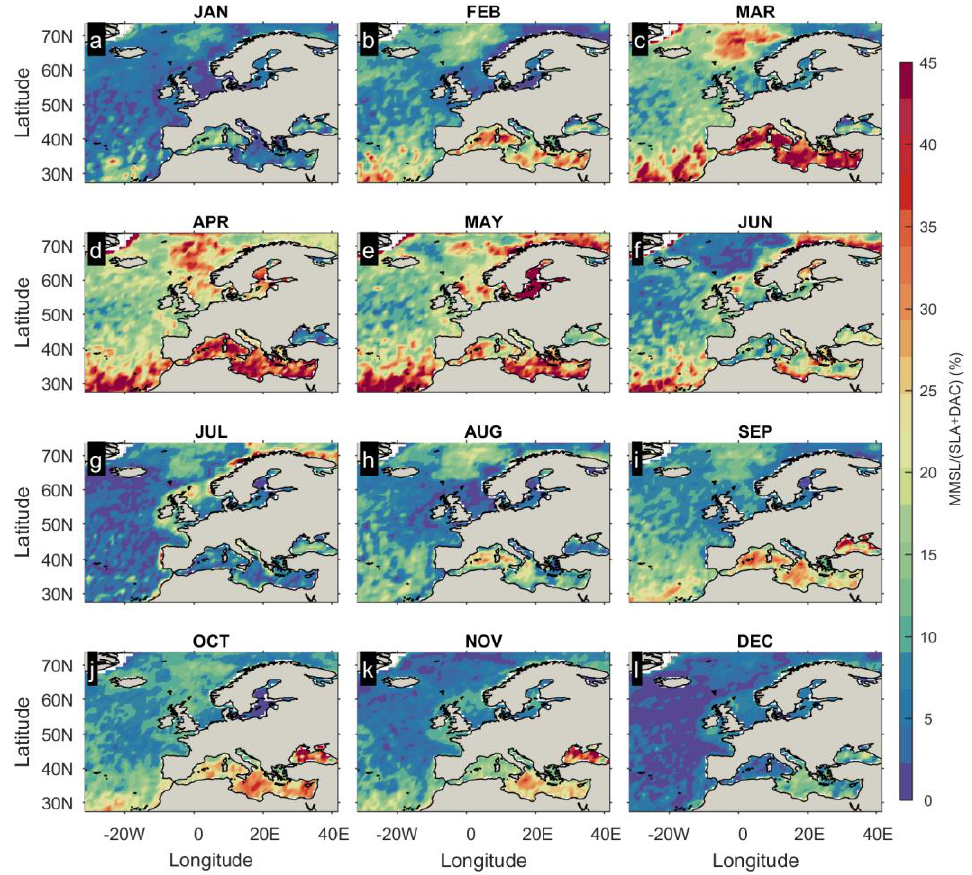
Figure 4. Seasonality of the annual contribution of the seasonal cycle of the MSL to the uncorrected monthly maximum MSL (Sea Level Anomaly (SLA) + Dynamic Atmospheric Correction (DAC)) (( a – l ) January-2a to December-2l).